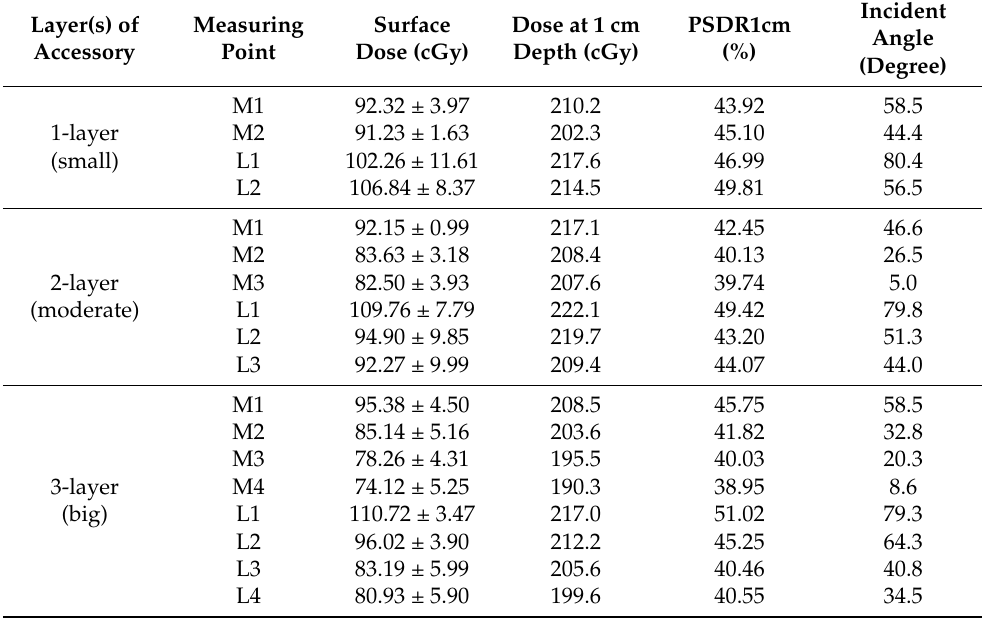
Table 2. The results of surface dose, incident angle and PSDR1cm in the medial-lateral direction on three different breast